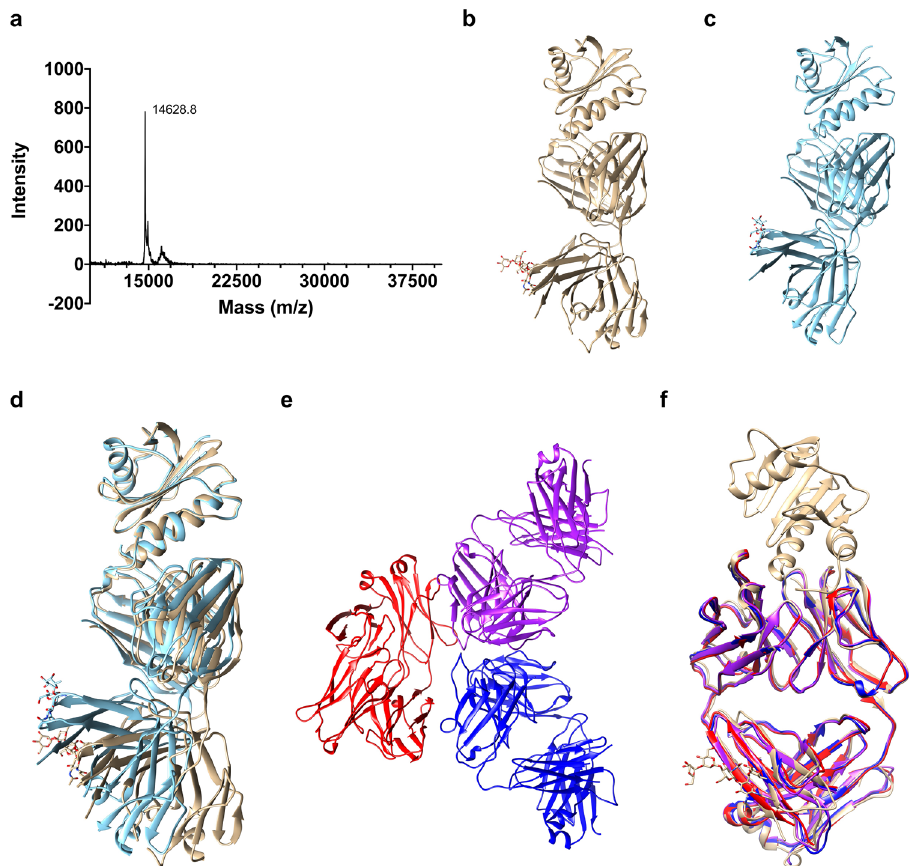
Fig. 2 Basis of allergen recognition through the free Fab/IgE 2F5 and the complex with DDDK-rHev b 8 structures. a MALDI-TOF spectrum for the DDDK-Hev b 8 construct. b and c Ribbon diagrams of the complex Fab/IgE 2F5-DDDK-rHev b 8 at 3.04 (gold) and 3.34 Å resolution (blue), respectively. d Fab constant domains show a displacement of 19.2 degrees due to fl exibility at the elbow region. e The three free Fab/IgE 2F5 molecules in the asymmetric unit (3.75 Å resolution). f Superposition of the three free Fab/IgE 2F5 molecules in the asymmetric unit (red, blue, and purple), with the complex Fab/IgE 2F5-DDDK-rHev b 8 at 3.04 Å resolution